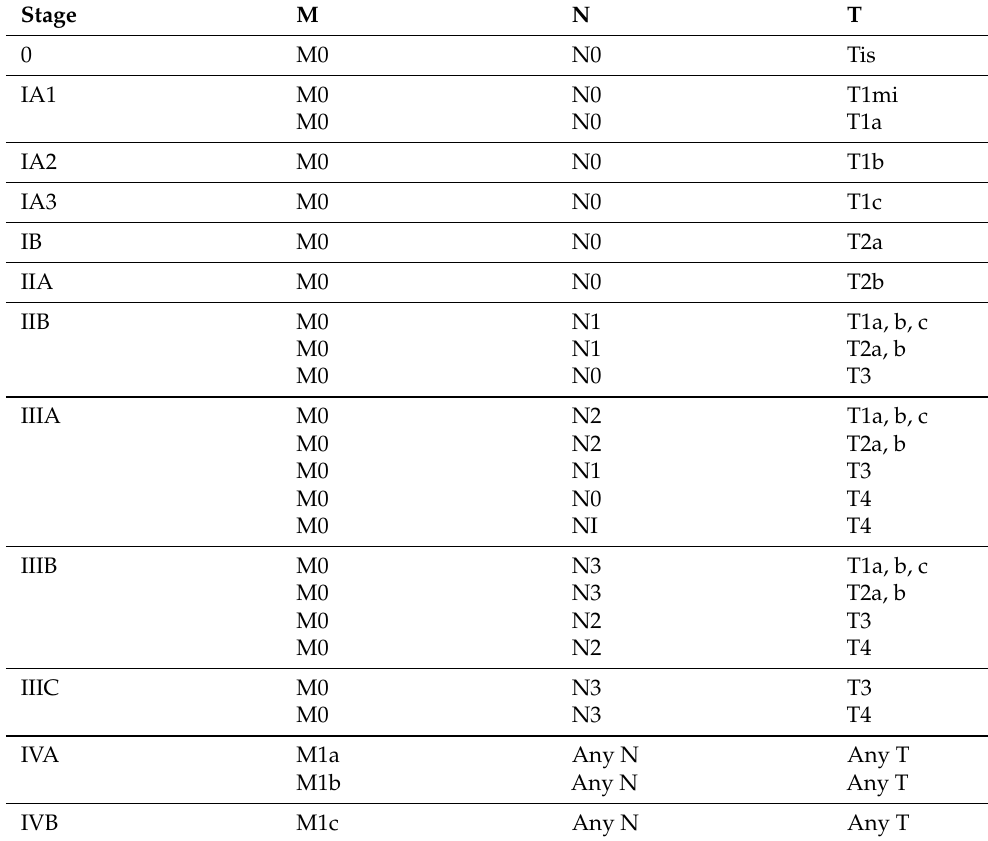
Table 2. Overall stage grouping of TNM lung cancer in the eighth edition [98,101]. Stage M N